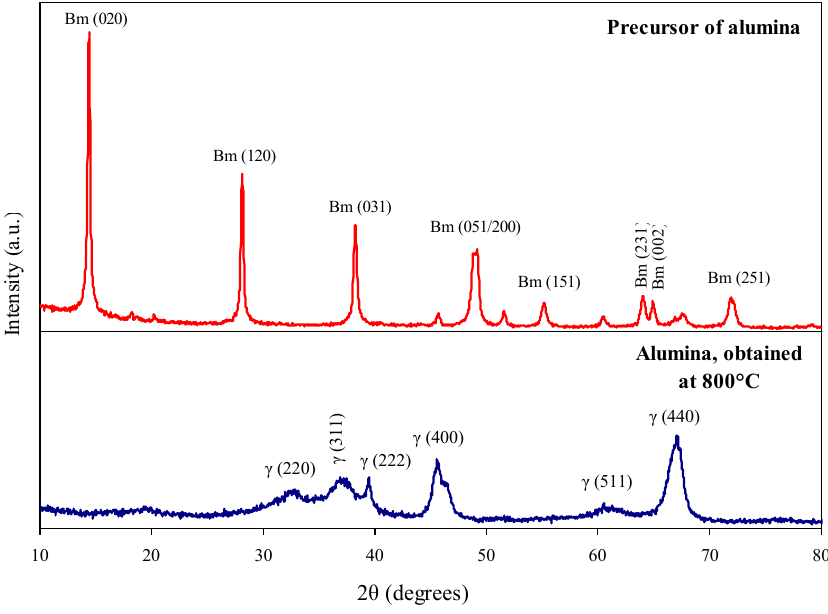
Figure 2. X-ray diffraction patterns of precursor of alumina and alumina support, obtained at 800 ◦ C. Table 1. Integral parameters of the porous system and the acidity of alumina supports.